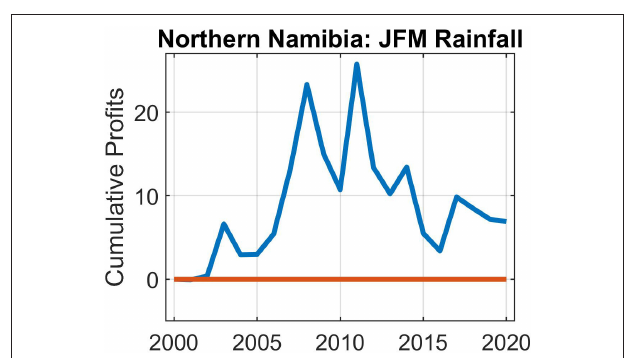
FIGURE 6 | Cumulative profits graph based on 9-years of probabilistic Dec-Jan-Feb rainfall forecasts for the farm located in the central interior of South Africa, to communicate the monetary value of probabilistic forecasts. The higher the amount of capital placed on a forecast that is correct, the higher the profit or return will be.